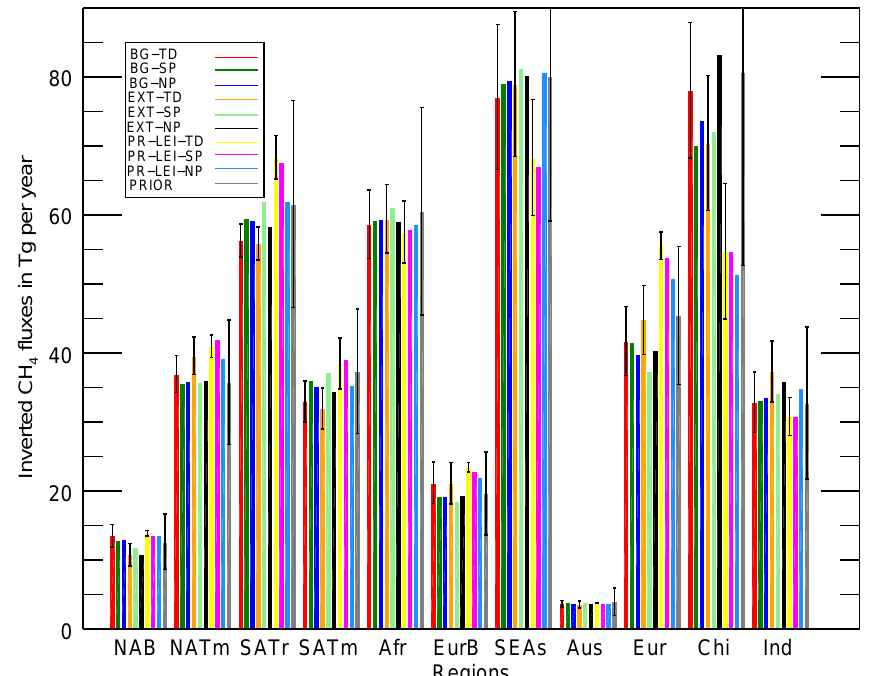
Figure 5. Estimations of methane fluxes (in TgCH 4 year − 1 ) for 11 regions in three versions of the model (LMDz-TD, LMDz-SP and LMDz-NP) and based on three different observation constraints (BG, EXT and PR-LEI). Prior error bars are overplotted on grey bars, which represent the prior estimations. Posterior error bars are plotted for LMDz-TD inversions only, and they have been estimated based on the work of Cressot et al. (2014). See Sect. 2.1 for more information on the analysis of posterior uncertainties. NAB: North America